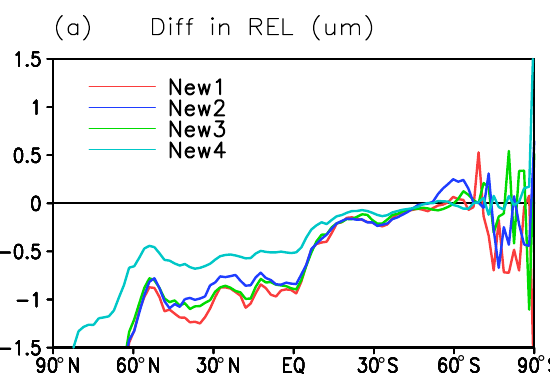
Figure 6. Annual zonal mean differences in the cloud-top effective radius (REL, µm) between PD and PI derived from News.